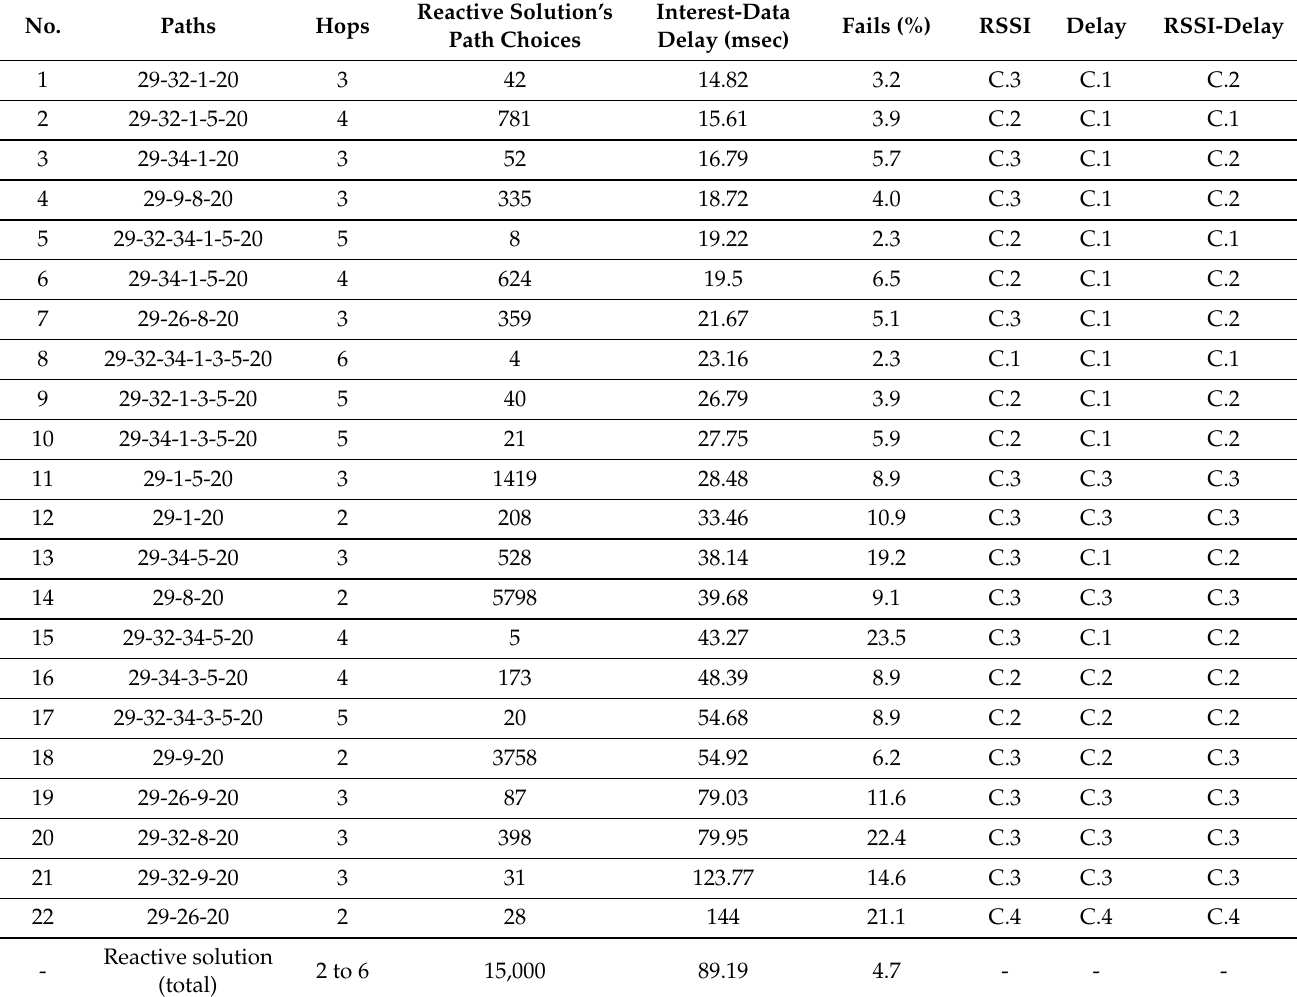
Table 5. Comparison of the clustering results with the reactive process, considering the average delay and fails (%) of 1500 interest-data exchanges, over each of the available NDN